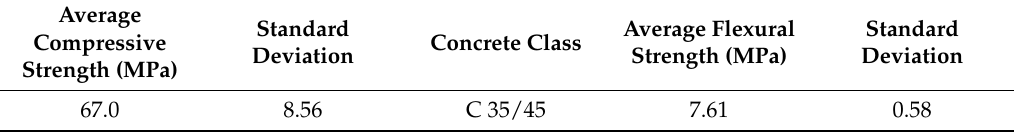
Table 2. Average test results of compressive and flexural strength of concrete